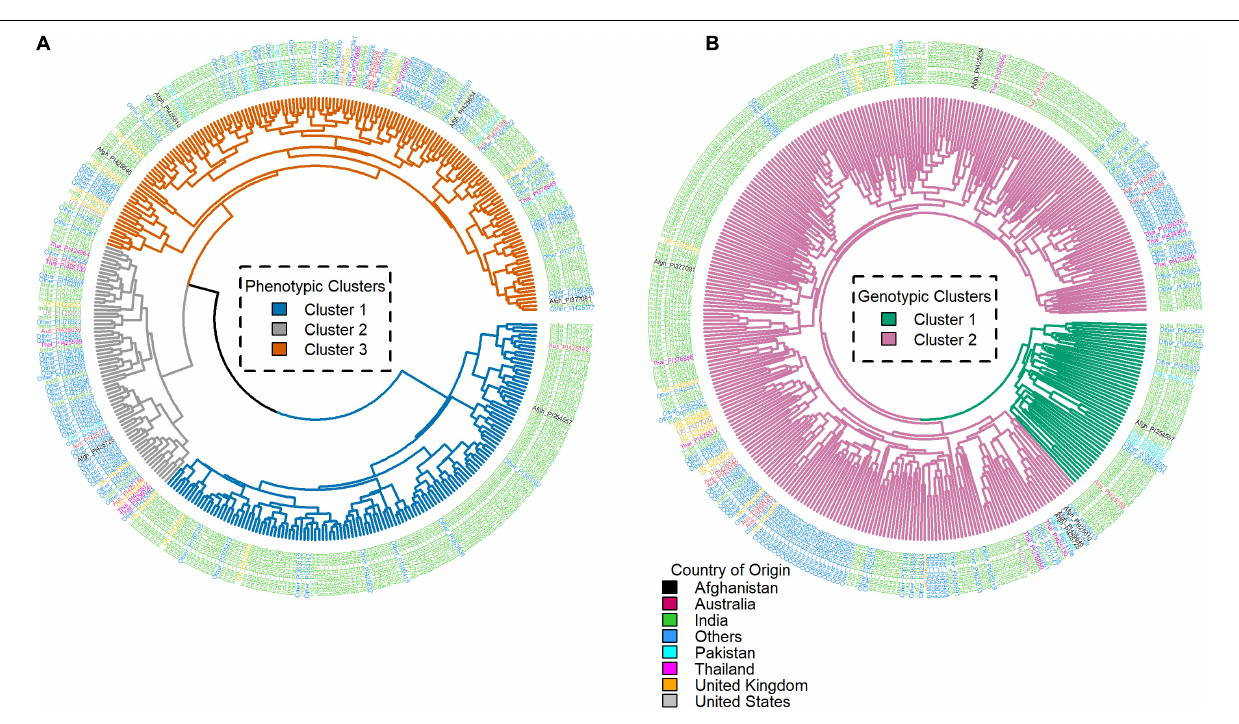
FIGURE 5 | Day 15 phenotypic (A) and genotypic (B) clusters of the root traits and single-nucleotide polymorphism (SNP) data, respectively, generated using hierarchical clustering of the core traits for all the genotypes. The labels represent the Plant Introductions (PI) and country of